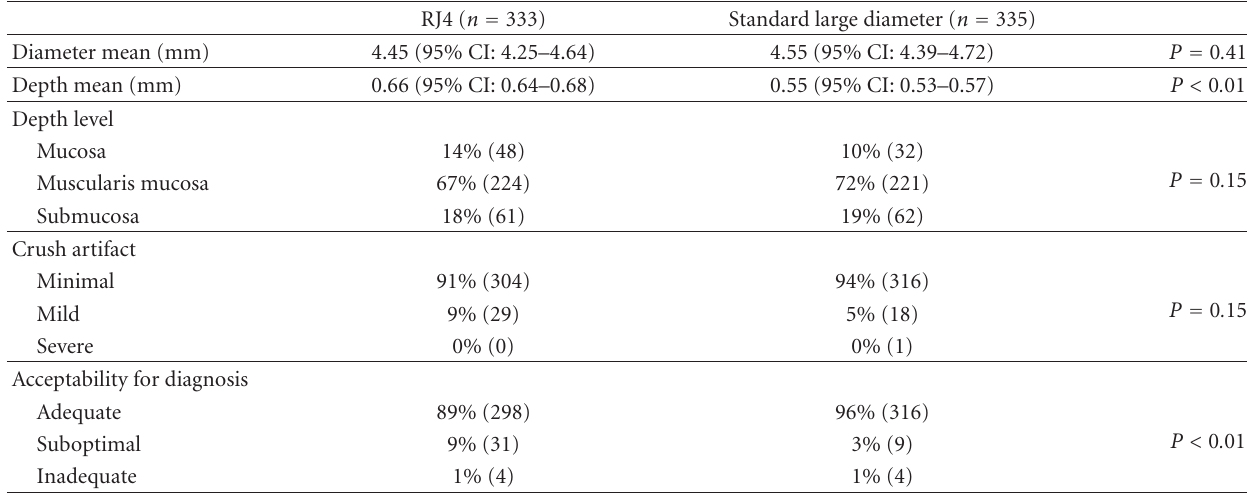
Table 2: Comparison of biopsy size and quality between RJ4 and standard large diameter